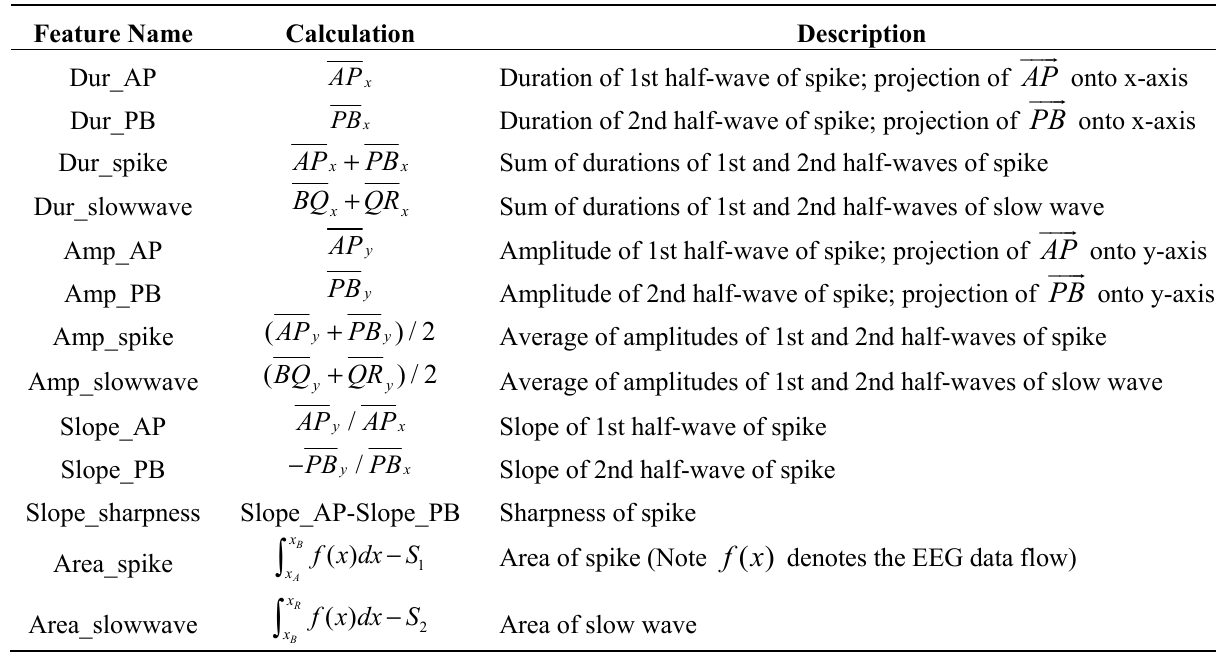
Table 2. Thirteen features analyzed in this study.